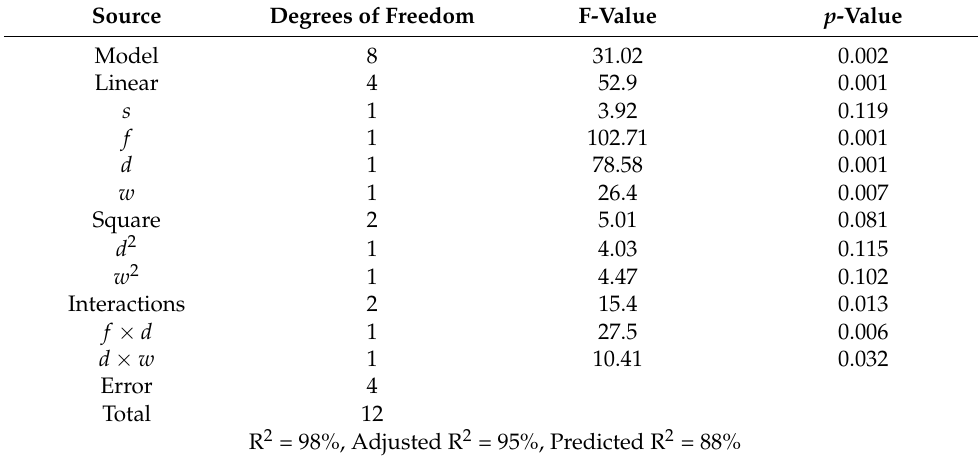
Table 5. Regression analysis of variance for cutting